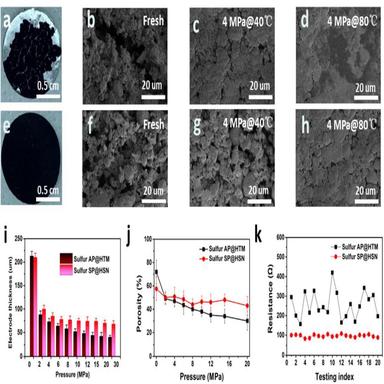
The calendering-compatibility of S-rich SP@HSN and its role in controlling the active material microenvironment inside composite electrodes. (a) and (b) Digital photo and SEM image of the sulfur AP@HTM electrode, respectively. (c) and (d) SEM images of the sulfur AP@HTM electrode after 4 MPa compression treatment at 40 and 80 °C, respectively. (e) and (f) Digital photo and SEM image of the sulfur SP@HSN electrode. (g) and (h) SEM images of the sulfur SP@HSN electrode after 4 MPa compression treatment at 40